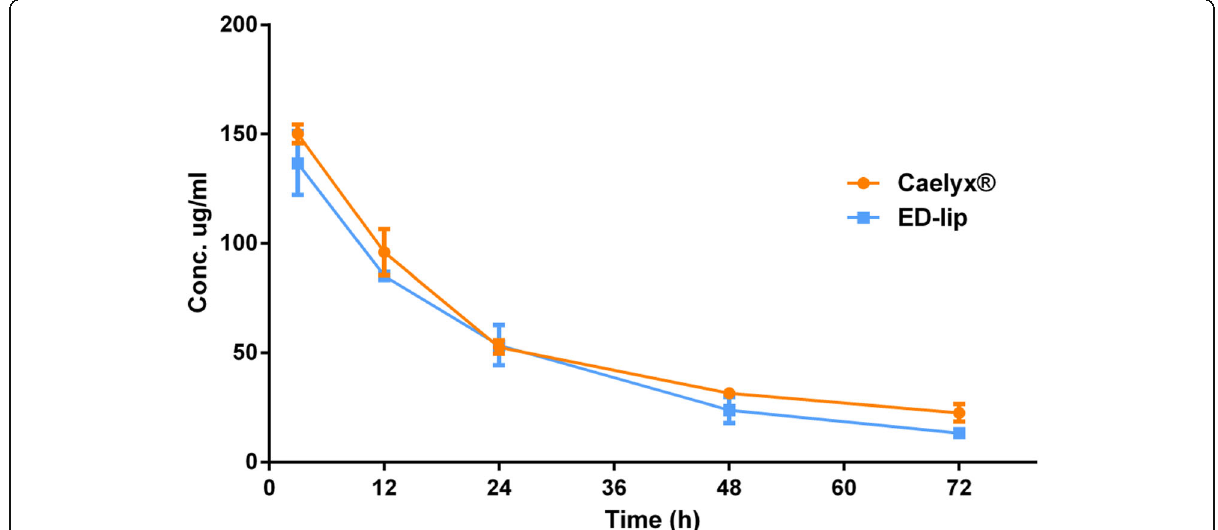
Fig. 7 Plasma level of DOX. The results of concentration against time of amount of DOX in blood at 3, 12, 24, 48, and 72 h post-injection. Data represented as mean ± standard deviation (SEM) ( n =